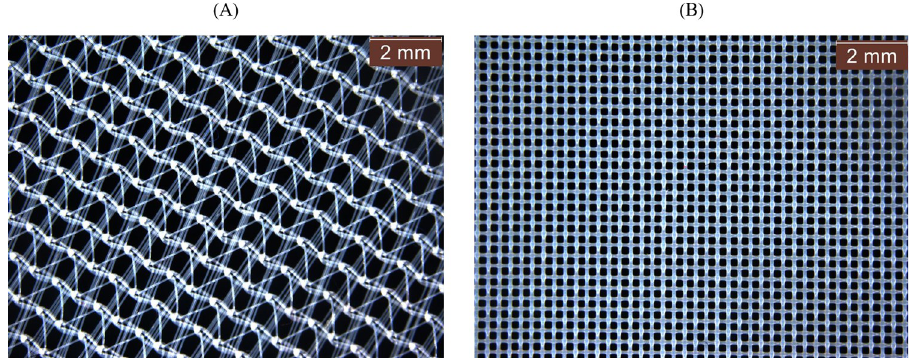
Fig 3. Lint filter mesh. Microscopy images of the mesh from the relatively coarse Indesit 1 ( A ) and fine Miele 1 ( B ) lint filters used to compare impact of lint filter pore size on microfiber collection.